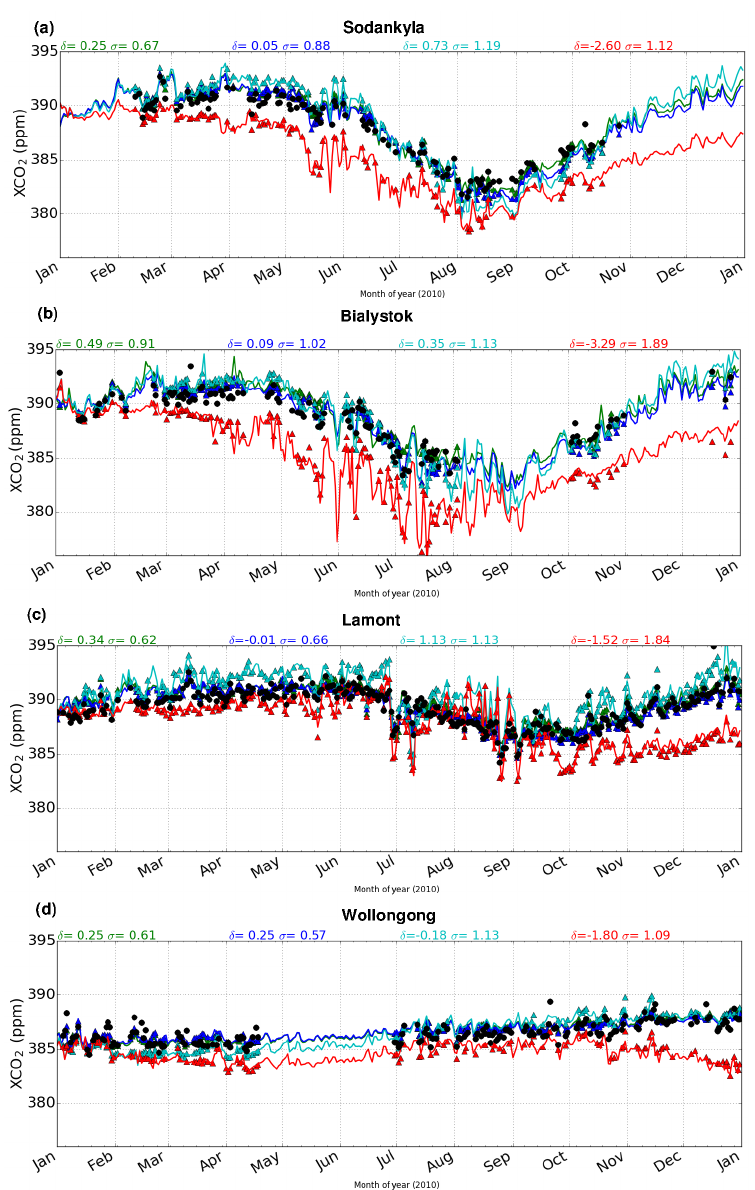
Figure 10. Daily mean atmospheric CO 2 column-average dry molar fraction (ppm) observed at four TCCON stations (see Table 3) as shown by the black circles, and simulated by the different forecast experiments: BFAS (cyan), CTRL (red), OPT (green) and OPT-CLIM (blue). See Table 2 for a description of the different experiments. The mean ( δ ) and standard deviation ( σ ) of the model errors are shown at the top of each